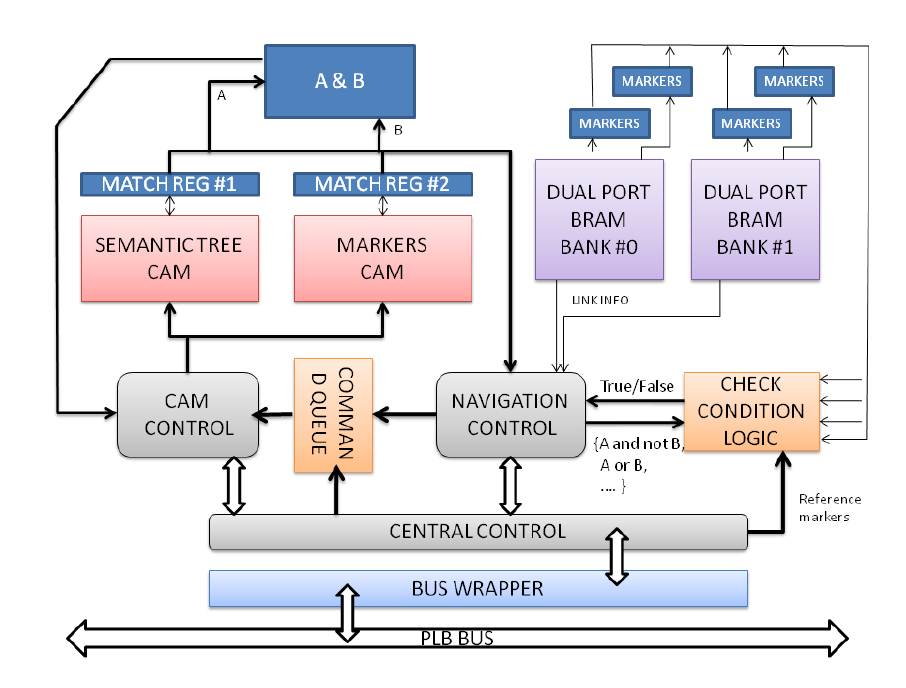
Figure 4. SN internal block